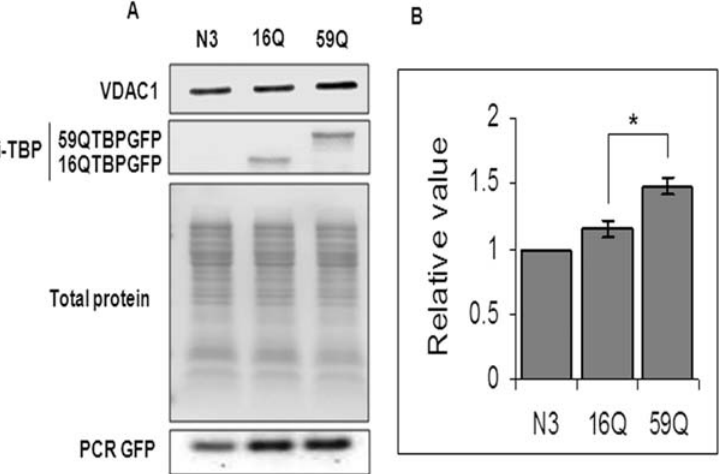
Figure 6. Expression of VDAC1 protein in Neuro-2a cells transfected with vector (N3), 16QTBPGFP and 59QTBPGFP. (A) Western blotting with VDAC1 specific antibody (N-18, Santa cruz) [upper panel], TBP specific antibody (N-12, Santa cruz) [middle panel]. Equal sample loading was verified by staining the blot with Ponceau S. DNA was isolated from transfected cells (see materials & methods) and equivalent amount of plasmid transfection was checked by PCR amplification using GFP specific primers (Table 1) (B) Immunoreactive band intensity was quantified and plotted. Data presented relative to the vector (N3) transfected control. Data shown are mean 6 SEM of three independent experiments performed. (*, p , 0.05, Student’s